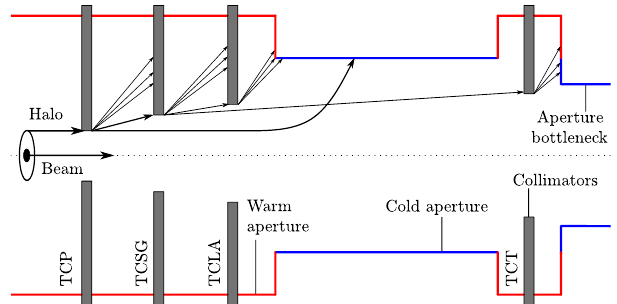
FIG. 1. Conceptual sketch of the layout of LHC collimators around the ring. Collimators are located mainly in IR3 and IR7, but also protect the experiments, the beam dump, and the injection